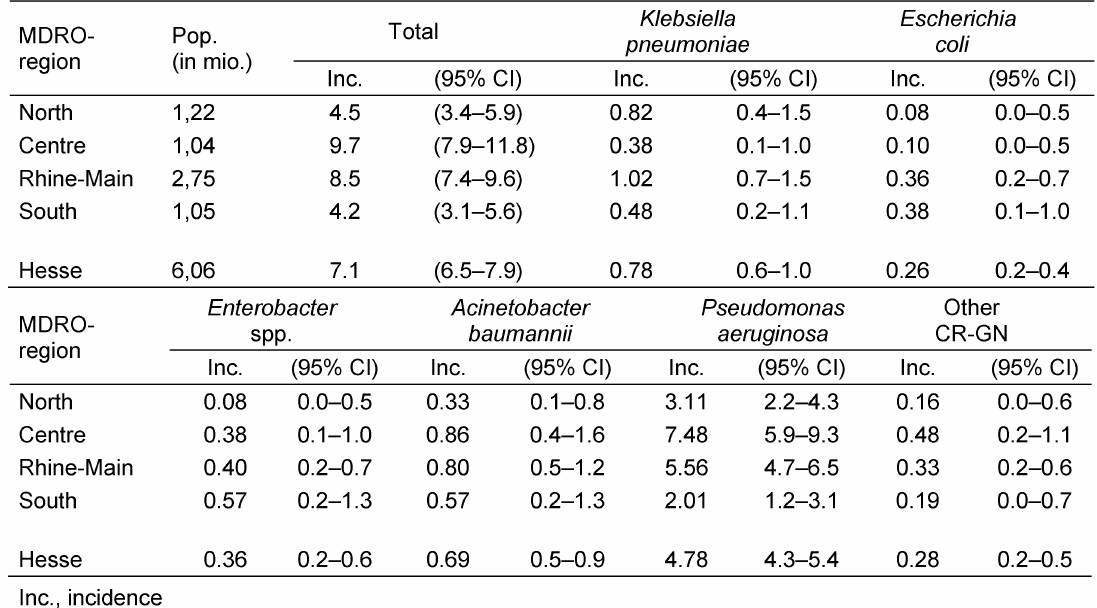
Table 4: Annual incidence (cases per 100,000 population) of all reported CR-GN-isolates, by species and MDRO-region, Hesse,